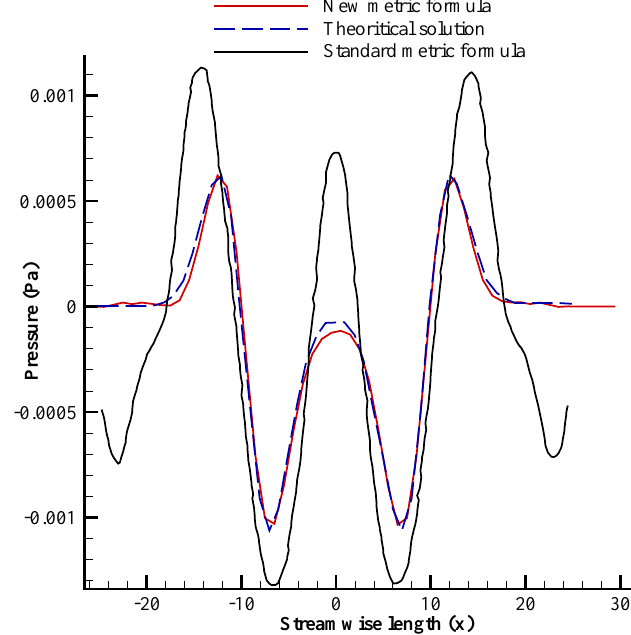
Figure 8. Comparison of computed pressure with the analytical solution showing the superior performance of the new metric cancellation